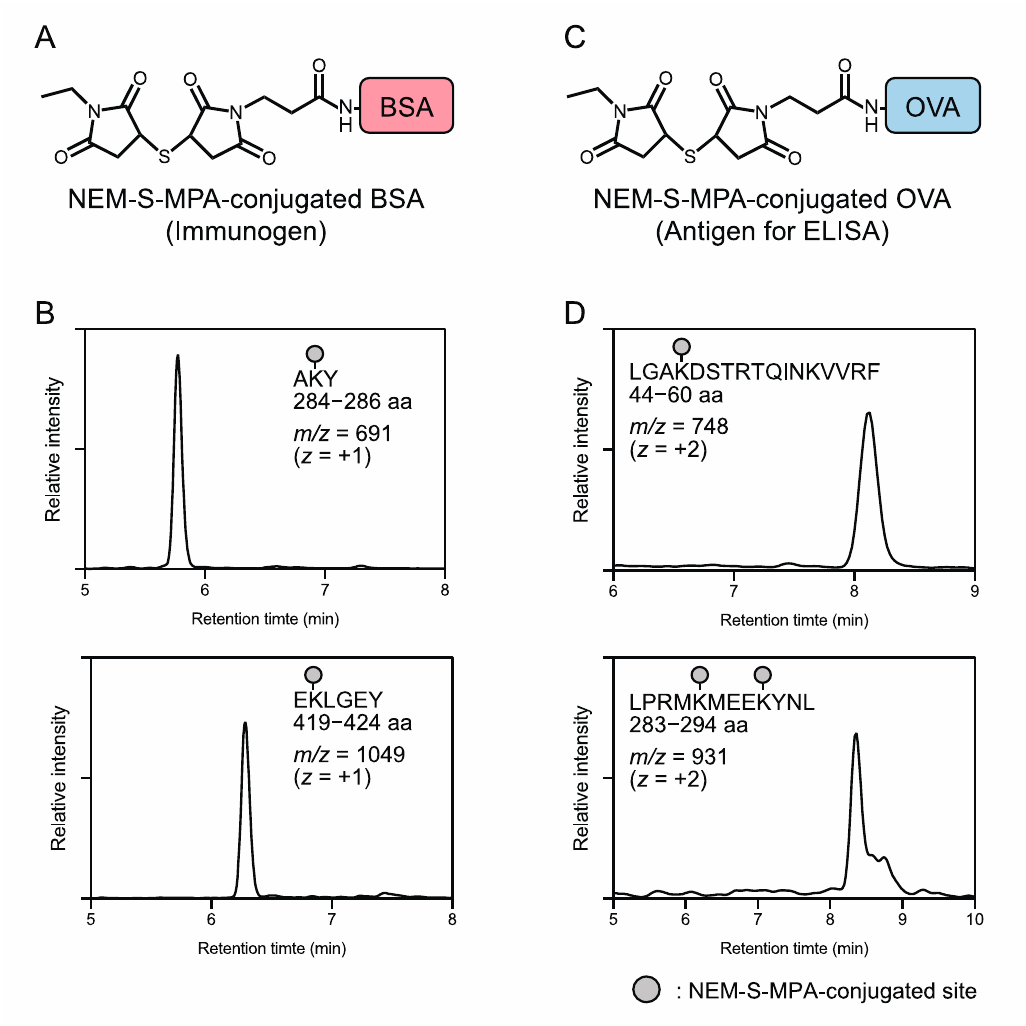
Figure 3. Preparation of immunogen and antigen. Immunogen ( A ) and antigen for ELISA ( C ) were prepared by a conjugation of NEM-S-MPA to bovine serum albumin (BSA) and ovalbumin (OVA), respectively. Representative MS chromatograms of peptide fragments containing NEM-S-MPA modifications derived from NEM-S-MPA-conjugated BSA ( B ) and OVA ( D ).